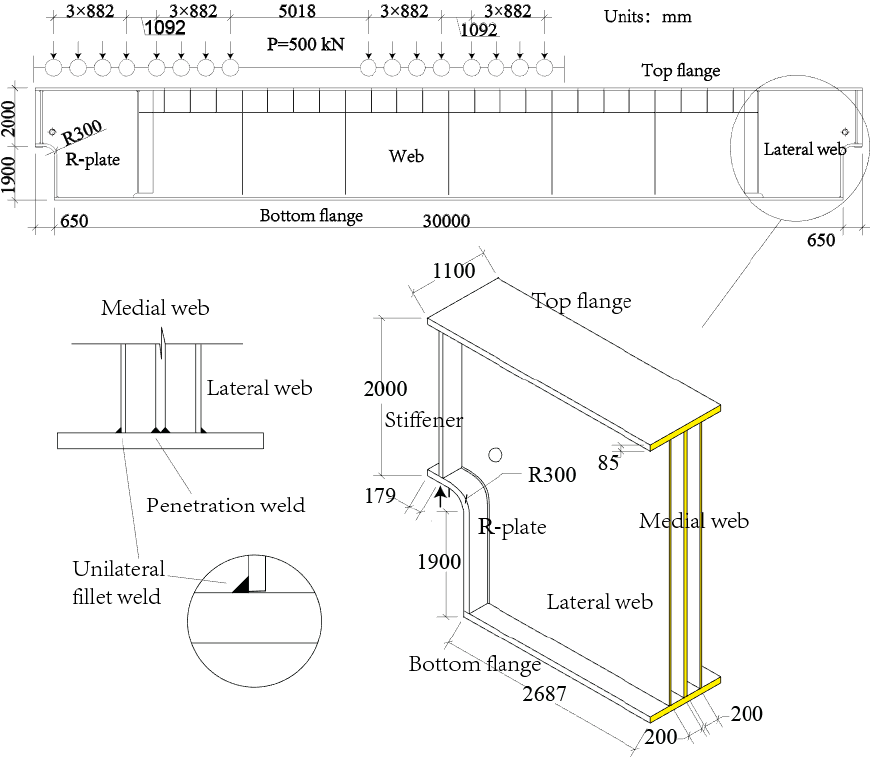
Figure 5. Dimensions and the most unfavorable load conditions of the variable-section supports with R-plates and three-web plates.